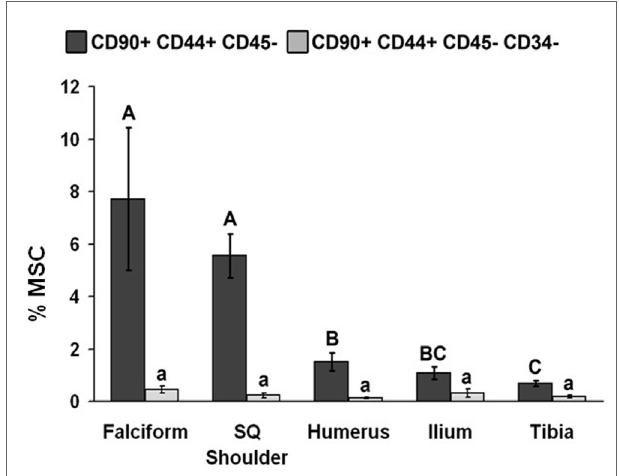
FigUre 2 | Percentage of Mscs from each extraction site (mean ± sD). Cells were designated as MSCs based on one of the two definitions: definition 1: CD90 + , CD44 + , and CD45 − (A–C); definition 2: CD90 + , CD44 + , CD45 − , CD14 − , and CD34 − (a–d). Different letters above bars indicate significant ( P < 0.05) differences among sites. In other words, those labeled with the same letter are not statistically different. Upper case letters indicate differences based on the analyses of three cell markers, whereas lower case letters indicate differences between analyses of five cell markers. Graph has been log